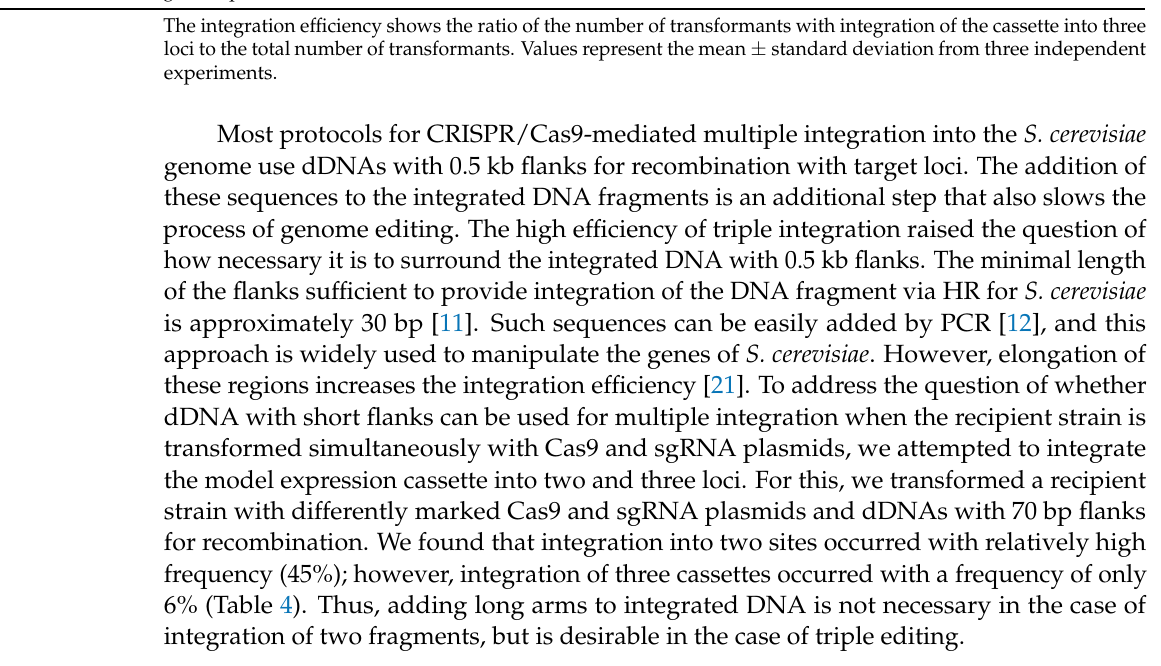
Table 4. The efficiency of integration of dDNAs with short arms for